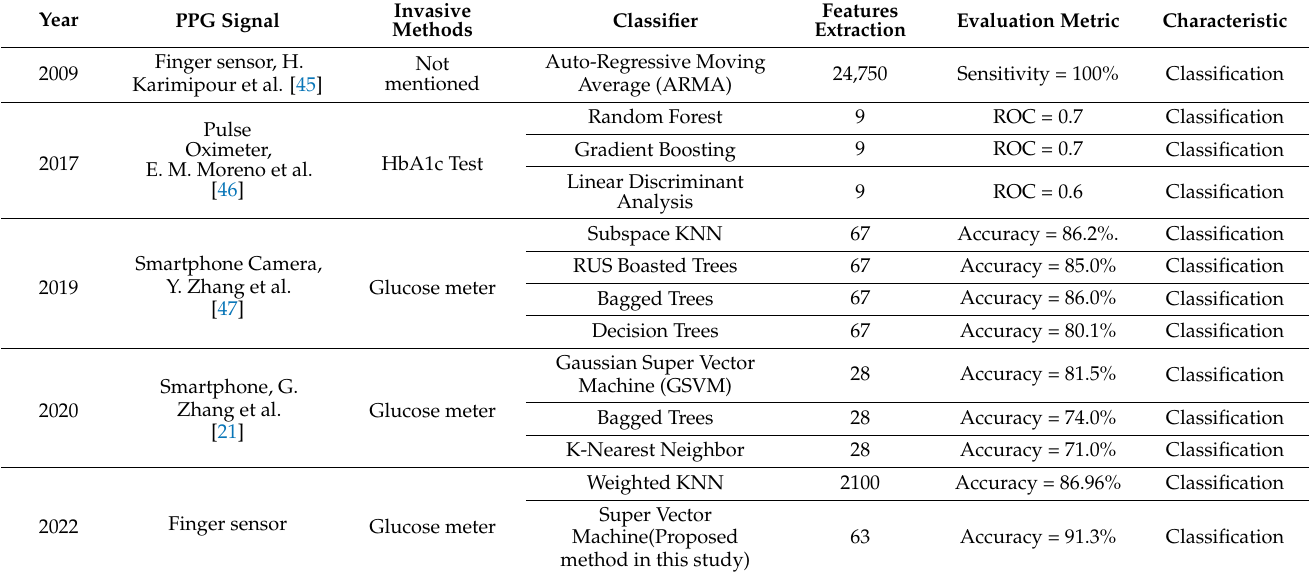
Table 9. Classification performance